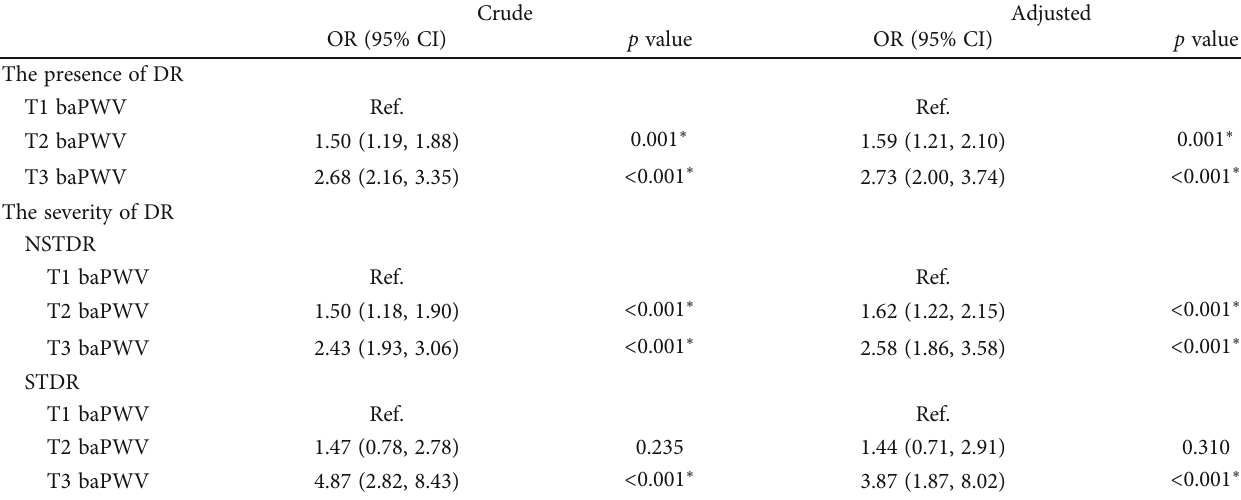
Table 1: Independent associations of tertiles of baPWV with the presence and/or severity of DR.